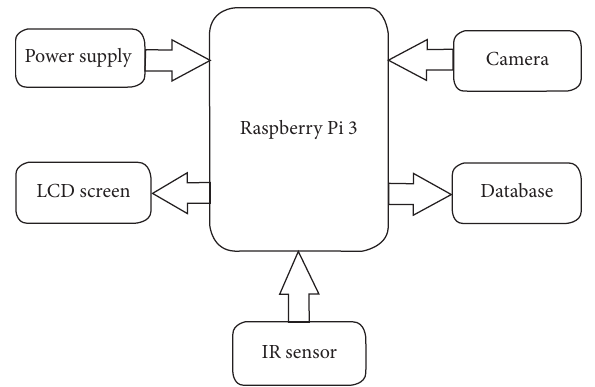
Figure 3: Block diagram of the proposed system.